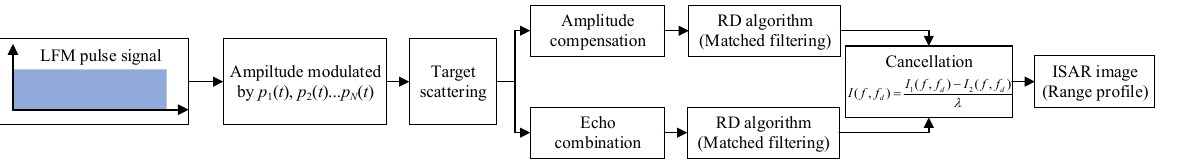
Figure 4. Imaging process based on amplitude modulation design.